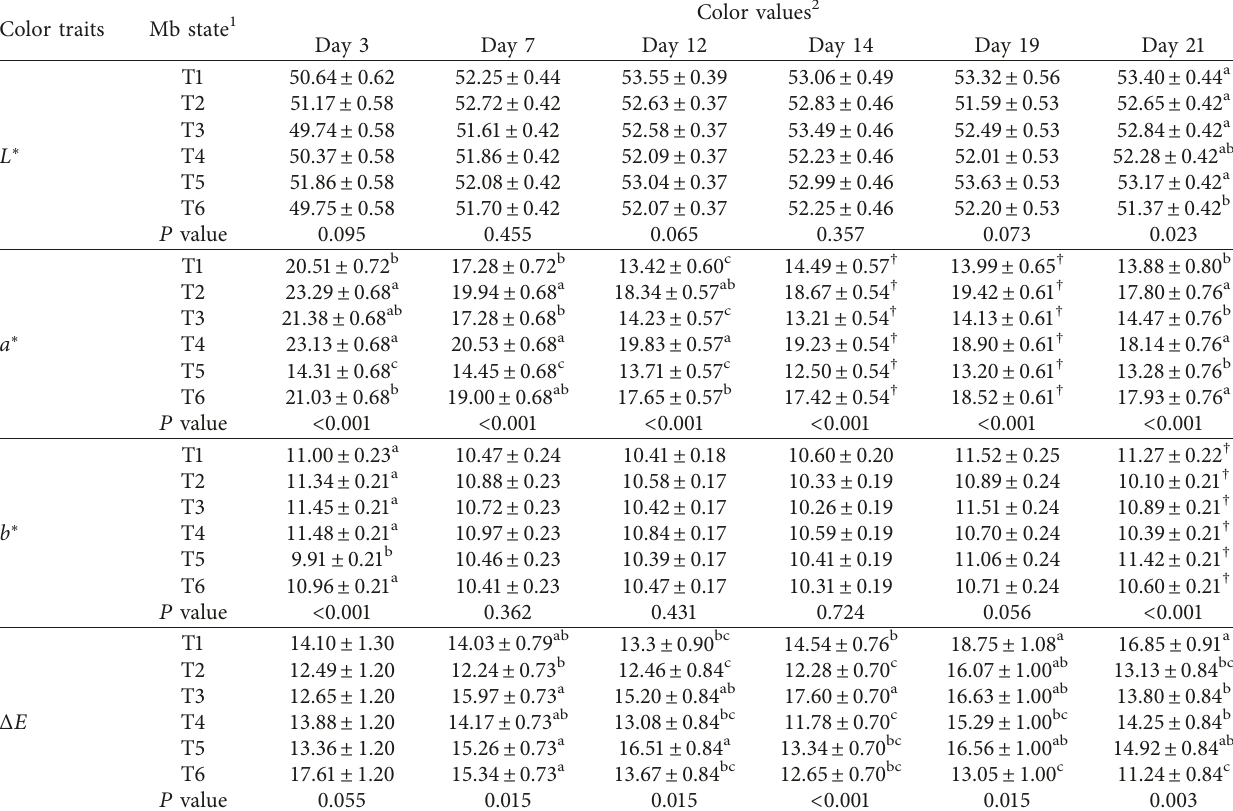
Table 2: Least square means ( ± SE) for main effect of myoglobin state (Mb) on color ( L ∗ , a ∗ , b ∗ ) and change in color ( Δ E ) during storage of ground beef